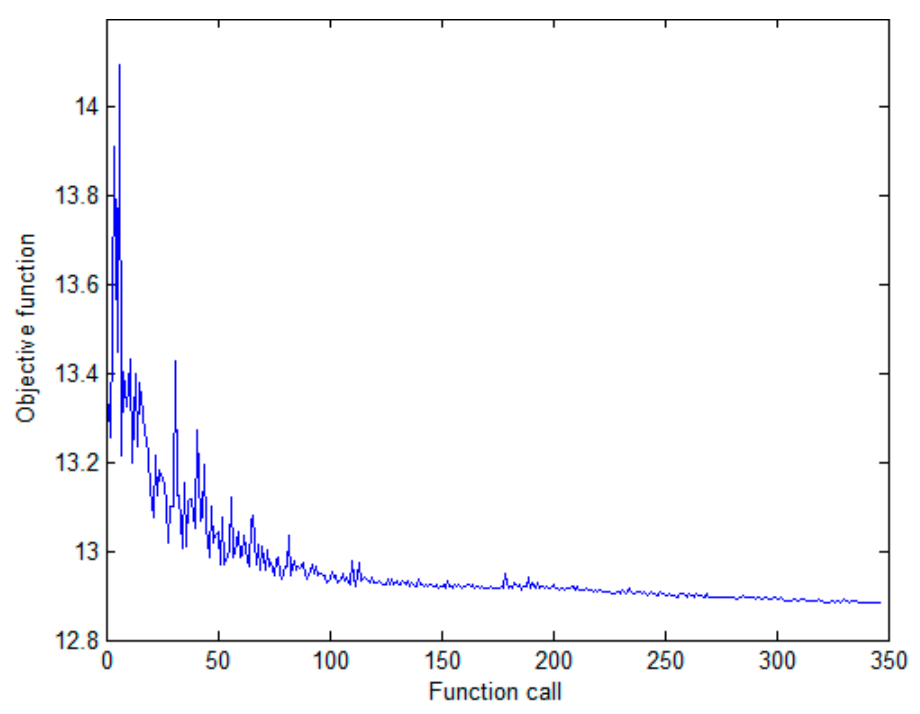
Figure 6. Variation of the cost function value during optimization.